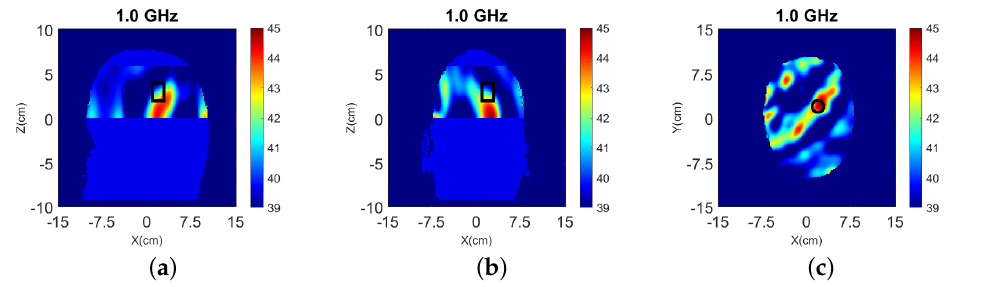
Figure 19. 3-D reconstructions of (cid:60) ( ε r ) for Case III.3 at 1.0 GHz: ( a ) y-z slice, ( b ) x-z slice, and ( c ) x-y slice. The headband of Figure 14 (with an increased distance between the array and the interface with air) is used to obtain the